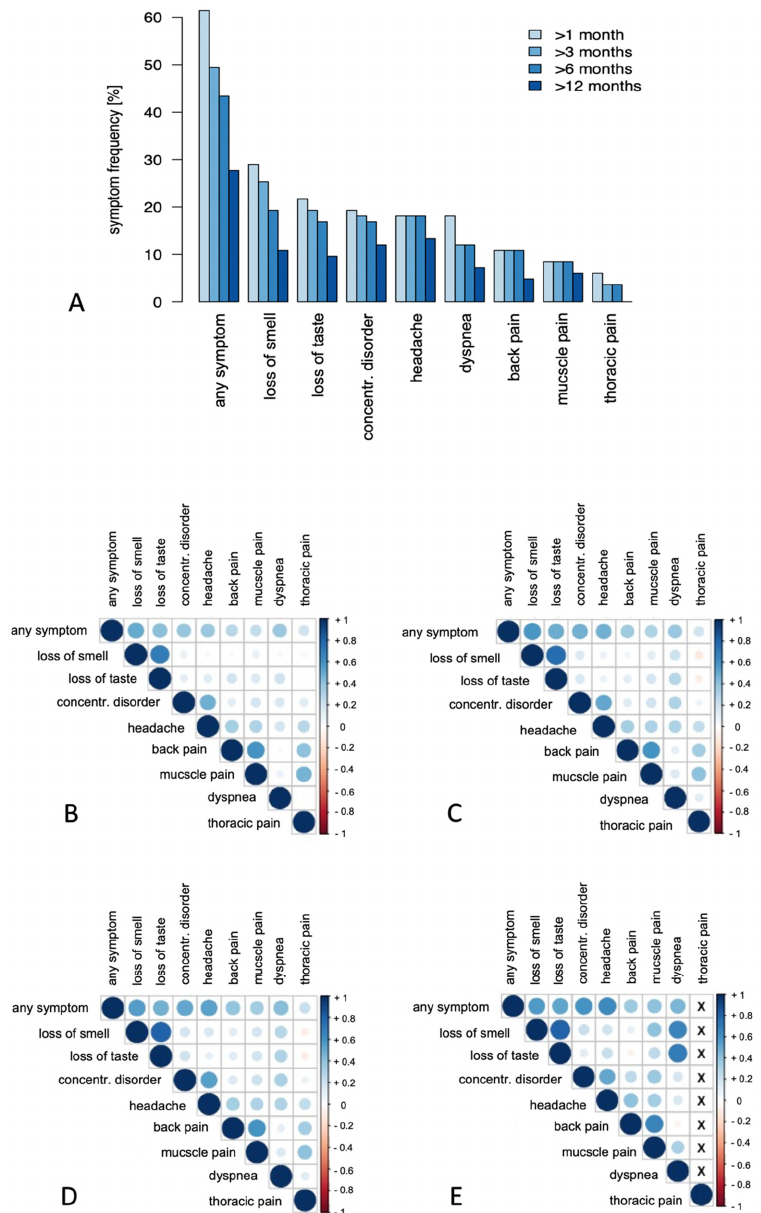
Figure 3. ( A ) Frequency of symptoms in patients after mild COVID-19 lasting at least 1, 3, 6 and 12 months, respectively, given in percentage. Correlation matrix displaying the co-occurrence of long-term symptoms for at least 1 ( B ), 3 ( C ), 6 ( D ) and 12 ( E ) months after COVID-19. Color intensity and the size of the circle are proportional to the correlation coefficients.